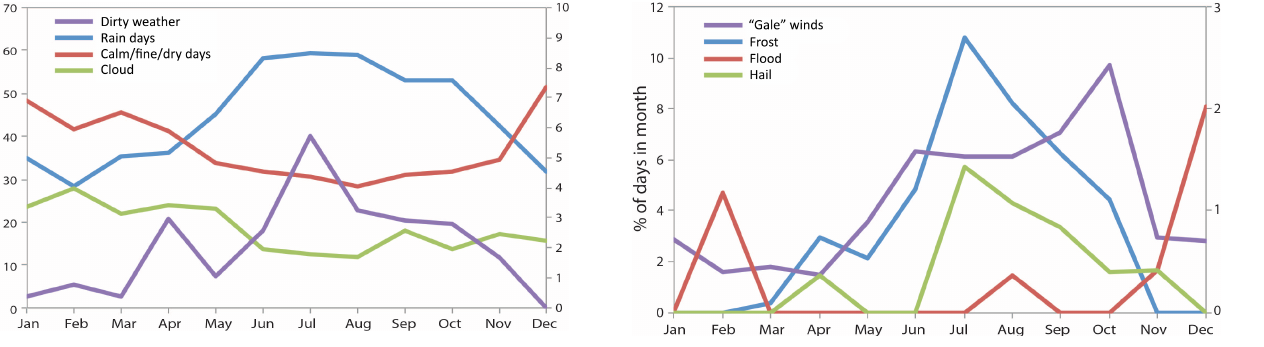
Figure 6. Climatology of qualitative observation for “gale” winds and frost days (left-hand scale) with flood and hail (right-hand scale) percentage of days per month in the Reverend Davis’ me- teorological